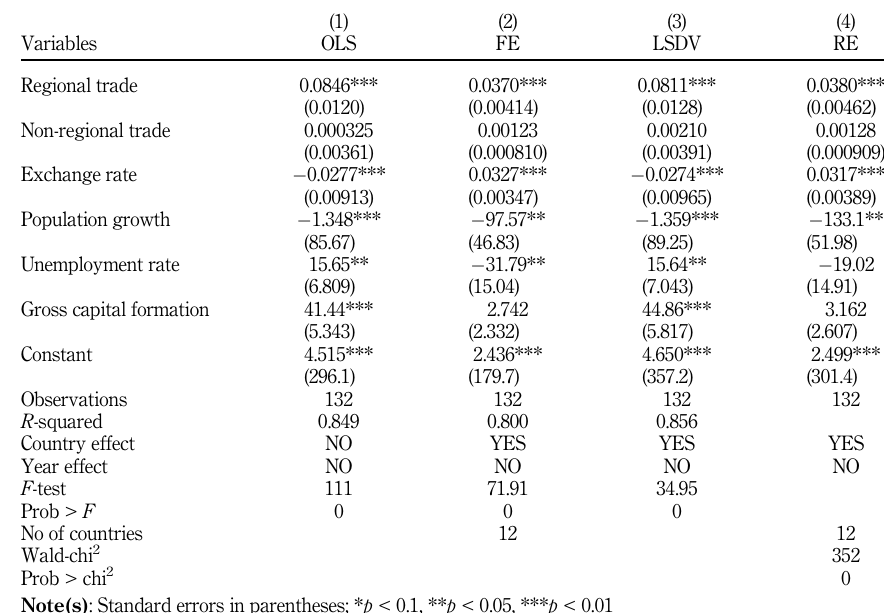
Table II. Static panel data